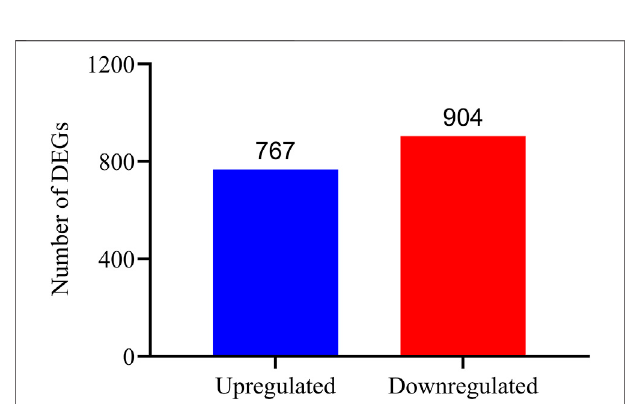
FIGURE2| Geneexpressionpro fi lesofcontrolandE β ftreatmenton3rd instar C.suppressalis larvae.Bluebarrepresents767signi fi cantlyupregulated genes while red bar represents 904 signi fi cantly downregulated genes in E β f treatment compared with expression levels of same in control.